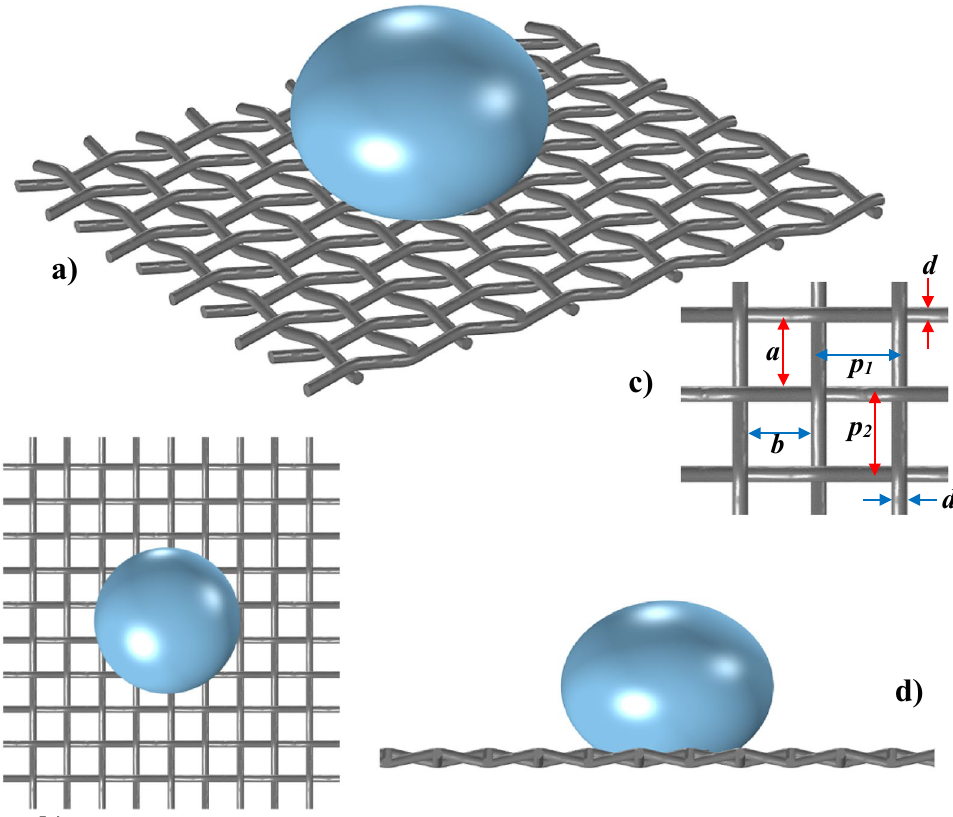
Figure 1. View of a sessile drop on hydrophobized mesh: ( a ) 3D view, ( b ) top view, ( c ) mesh dimensions, and ( d ) side